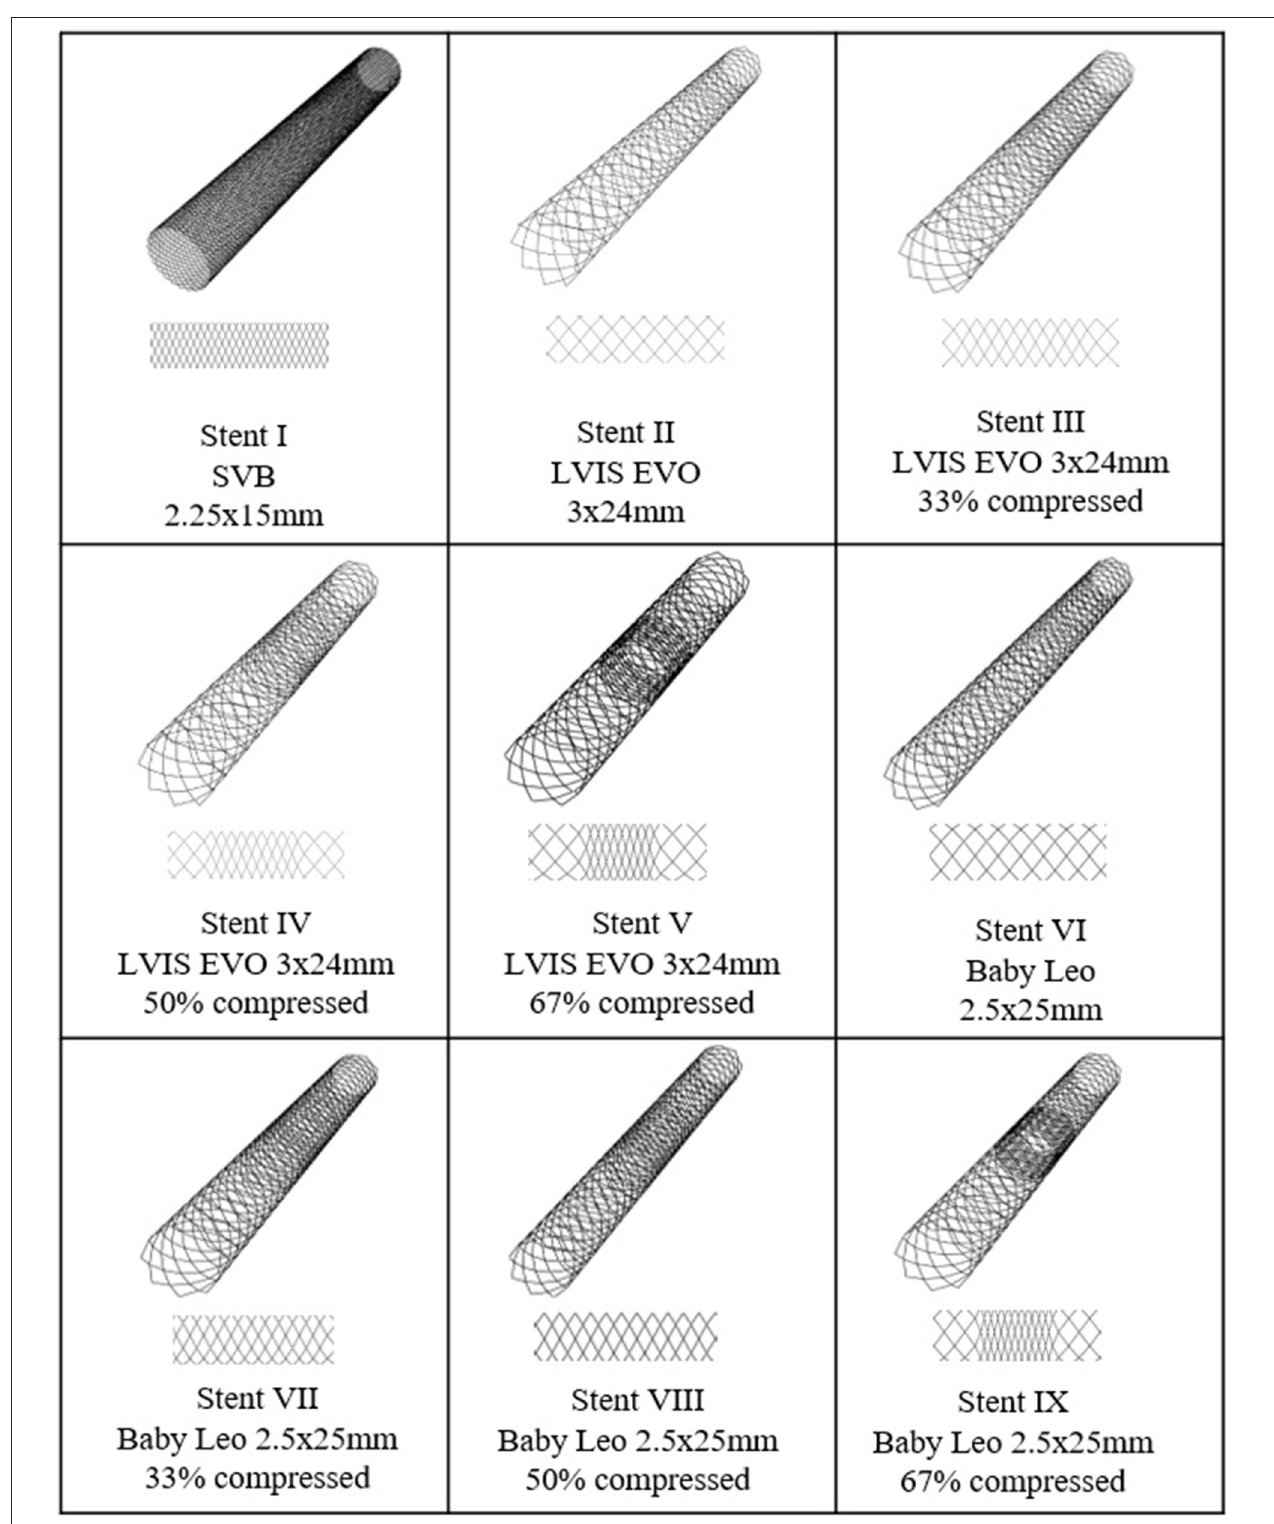
FIGURE 2 | SVB, LVIS EVO, and BABY LEO designs to be virtually deployed in each WNBA geometry. Stent I is flow-diverting stent whereas stent II–VIII are low-profile braided stents with different compression level at mid third part of the devices.